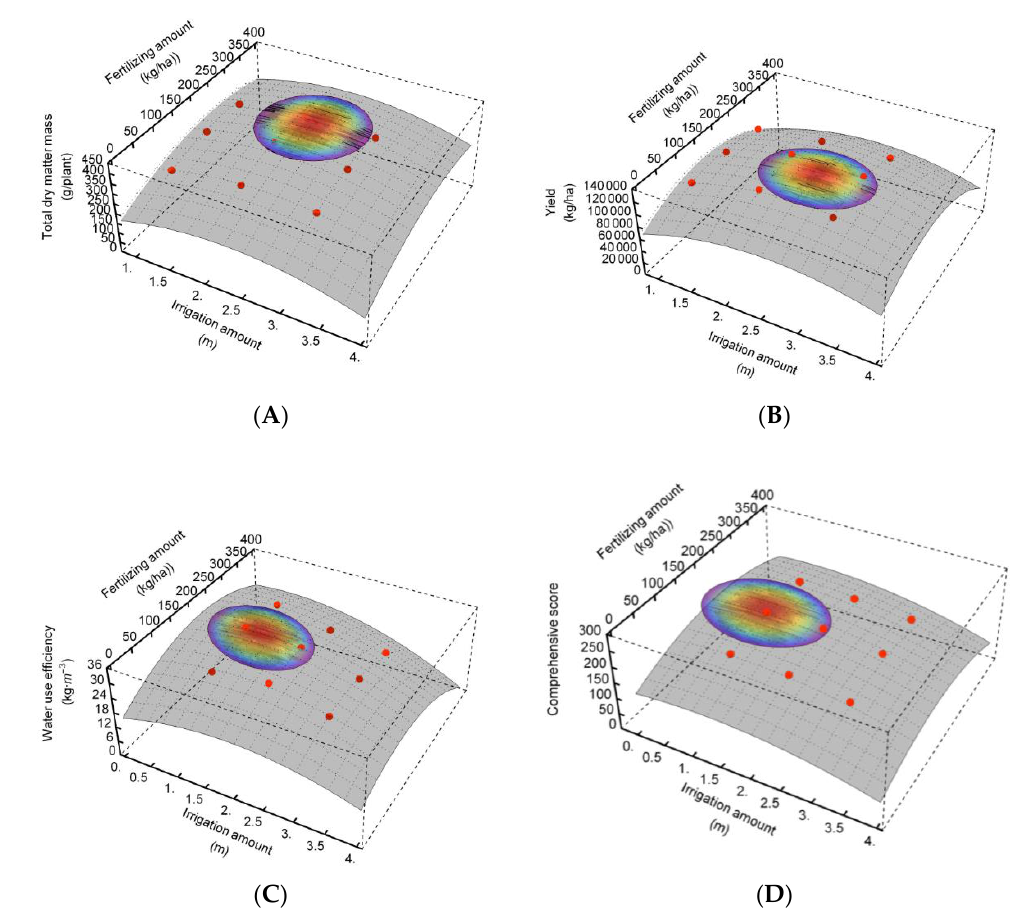
Figure 5. Spatial analysis. Note: The circular dotted points in the figure represent the measured and calculated value of total dry matter mass of tomato ( A ), yield of tomato ( B ), water use efficiency of tomato ( C ), comprehensive score of tomato quality ( D ). The shadow regions represent 95% confidence interval of maximal comprehensive score.